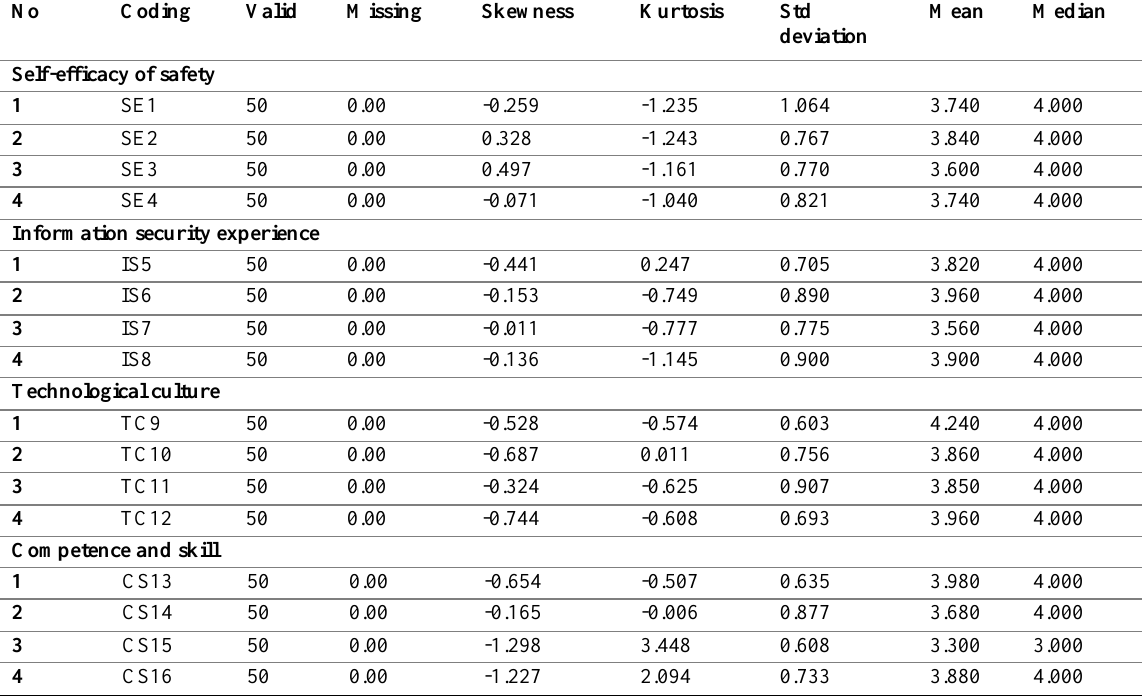
Table 1: The results of the normal distribution of the financial technology variable